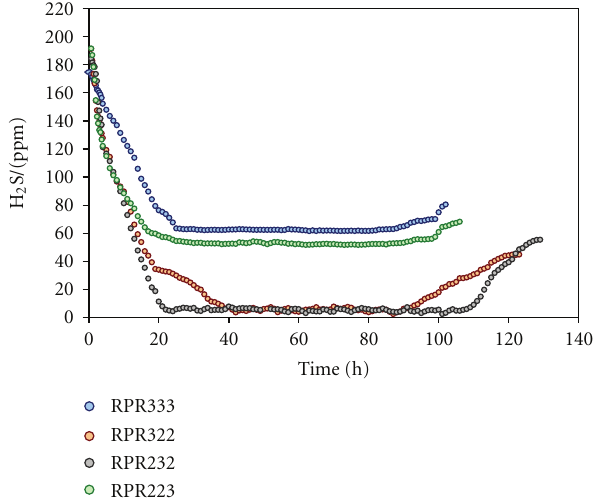
Figure 8: Trend in H 2 S concentration profile for trimetallic catalysts with time